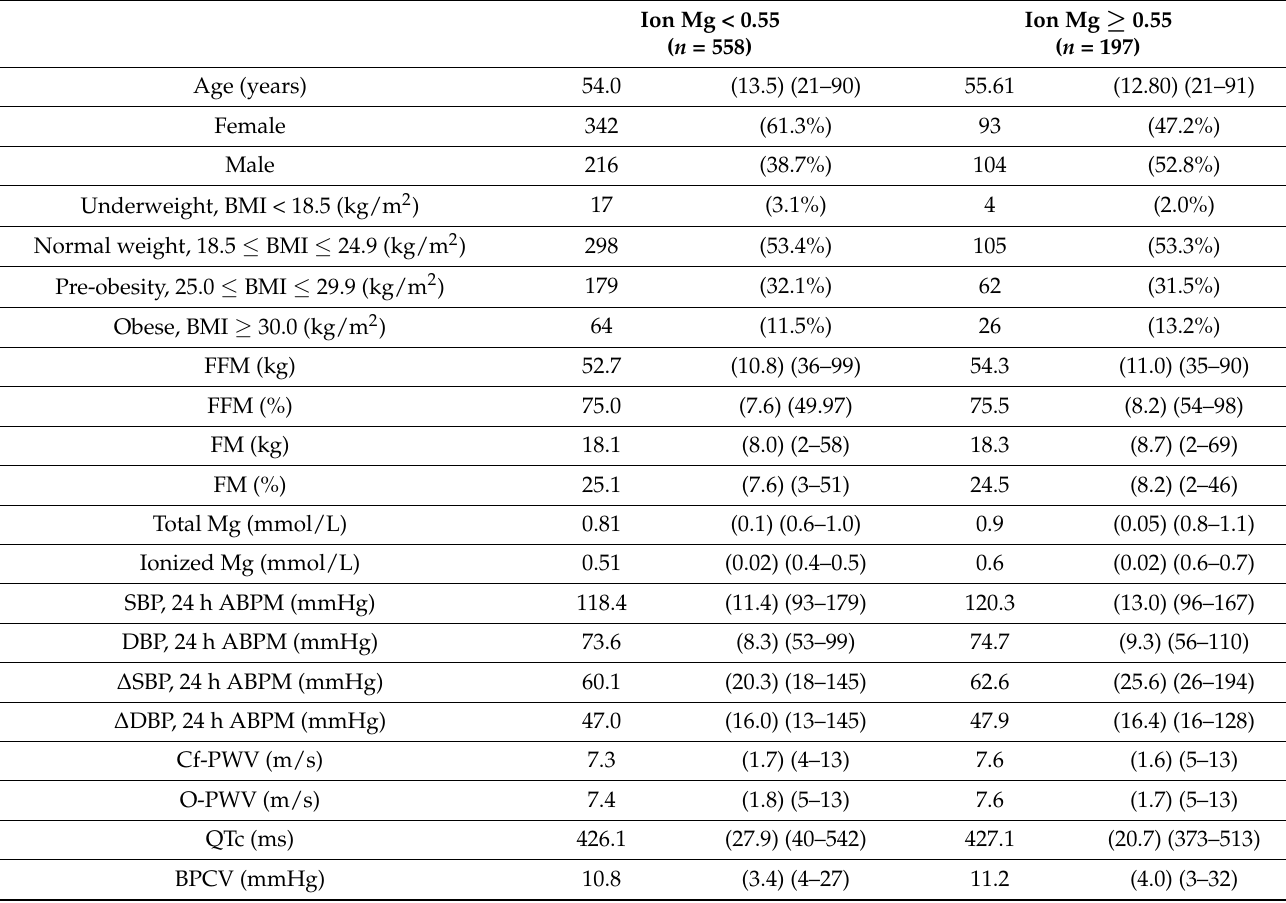
Table A7. Patients’ characteristics—Ionized Magnesium Classification